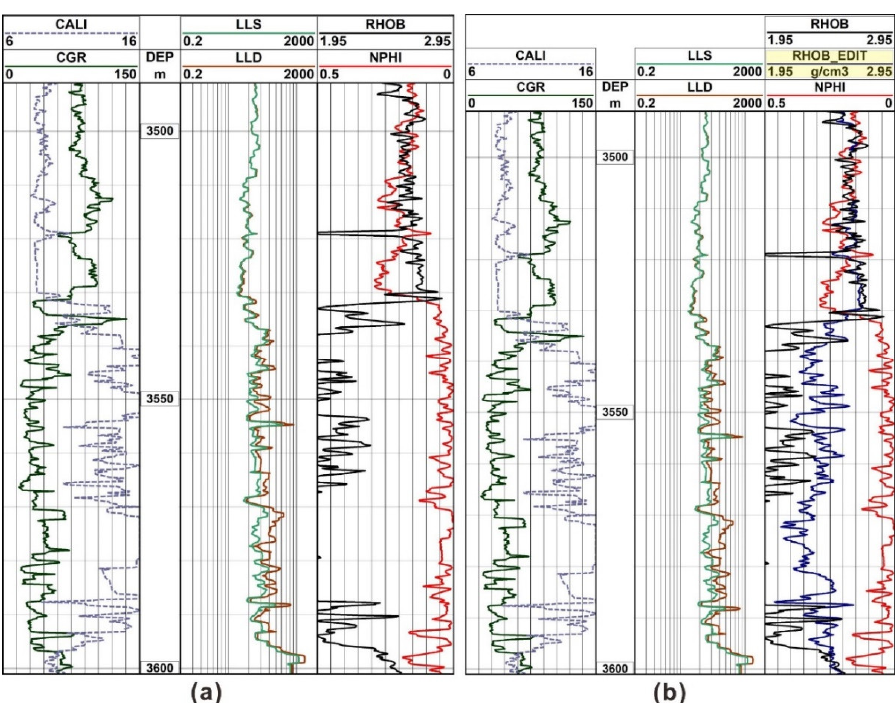
Figure 3. ( a ) Measured RHOB curve on track-4 (black) for Remat-02 well requires conditioning. ( b ) Synthesized RHOB curve (blue) on top of measured RHOB curve. The yellow box on track-4 shows the corrected RHOB curve.